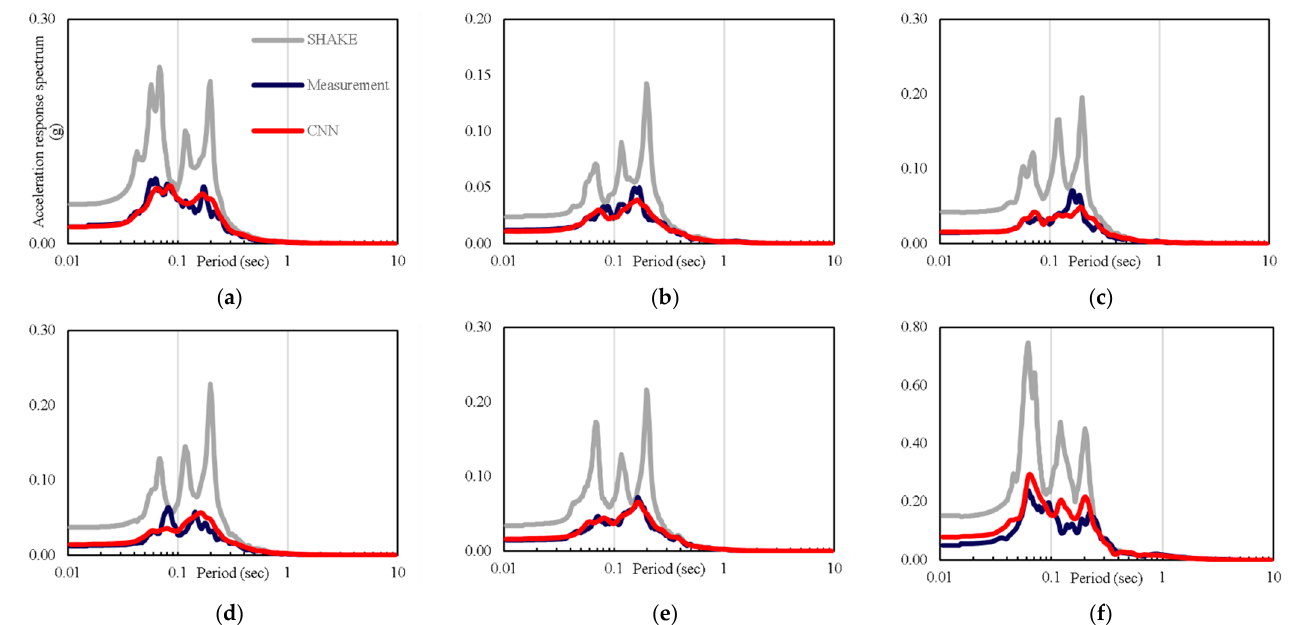
Figure 18. The six samples of acceleration response spectra measurements and predictions at site IWTH21. ( a ) IWTH211310260210.EW. ( b ) IWTH211601141225.EW. ( c ) IWTH211611220559.NS. ( d ) IWTH211801241951.NS. ( e )